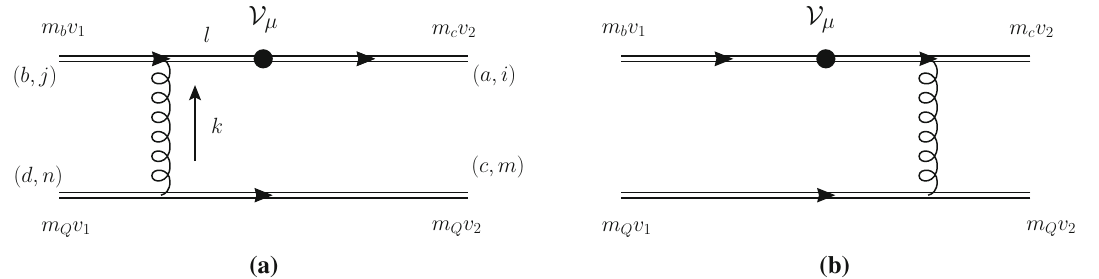
Fig. 1 Diquark transition at the quark level. Single gluon exchanges between the two heavy quarks are explicitly shown, with the quantum numbers of the quarks are denoted as (spinor index, color